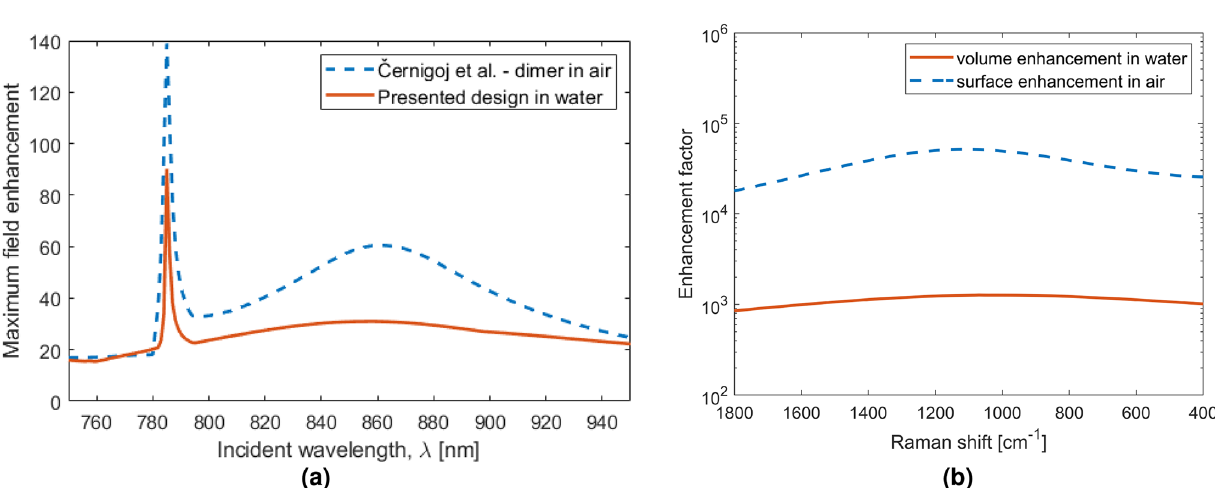
Figure 3. ( a ) Maximum local field enhancement within the unit cell of the crystalline silicon dimer metasurface in water and air, with plane wave incident light polarized along the axis through the centre of both cylindrical nanoparticles. Sweeping incident wavelengths from 750 to 950 nm, shows a narrow peak at 785 nm due to the lattice resonance, the array field enhancement (AFE) and a broad peak at 862 nm due to the dimer resonance, the dimer field enhancement (DFE). ( b ) Enhancement factor using a excitation wavelength of 785 nm, averaged over the unit cell fluid volume for the SERS substrate in water and averaged over the surface of the SERS 1 substrate in air, for Raman shift values between 400 and 1800 cm −